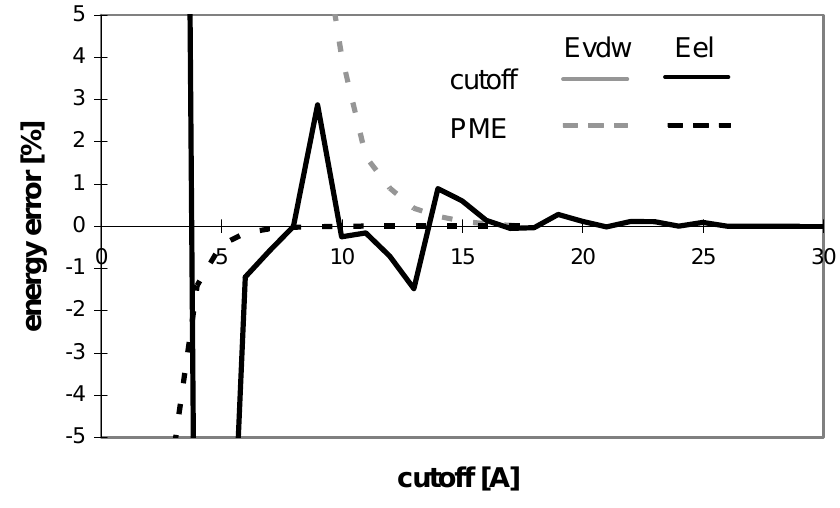
Figure 12. Dependency of energy on cutoff for (nucleotide-sugar N3). For energy error definition see Fig. 1.